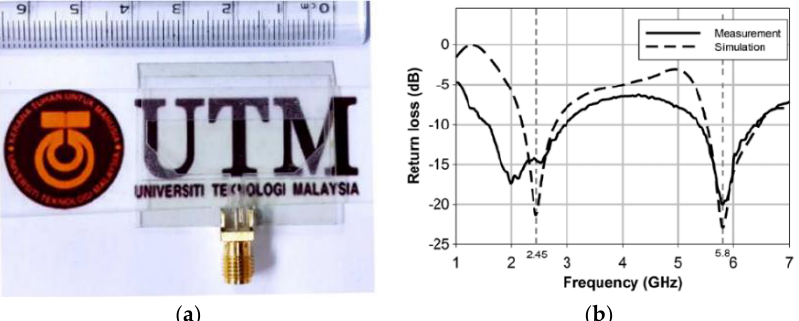
Figure 9. ( a ) Photograph of the fabricated antenna using the AgHT-8 transparent thin film; ( b ) simulated and measured return loss of the proposed antenna [34]. (With permission from IEEE).